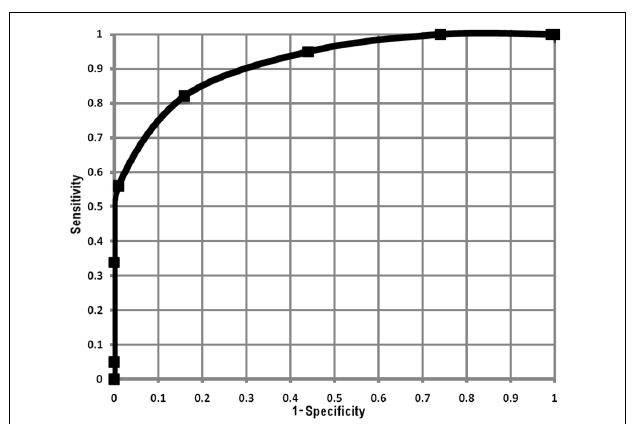
FIGURE 6 | Receiver operating curve calculated from average HFD values within the experimental phases, for each healthy and diabetic subject (in total 140 HFD values for healthy and 85 for diabetic